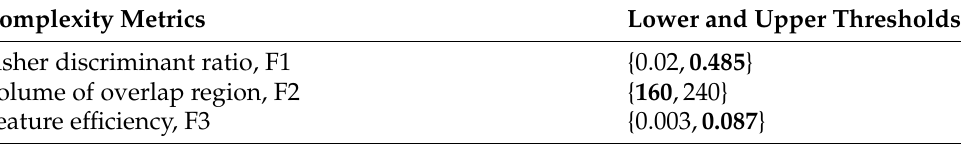
Table 4. Thresholds for the complexity